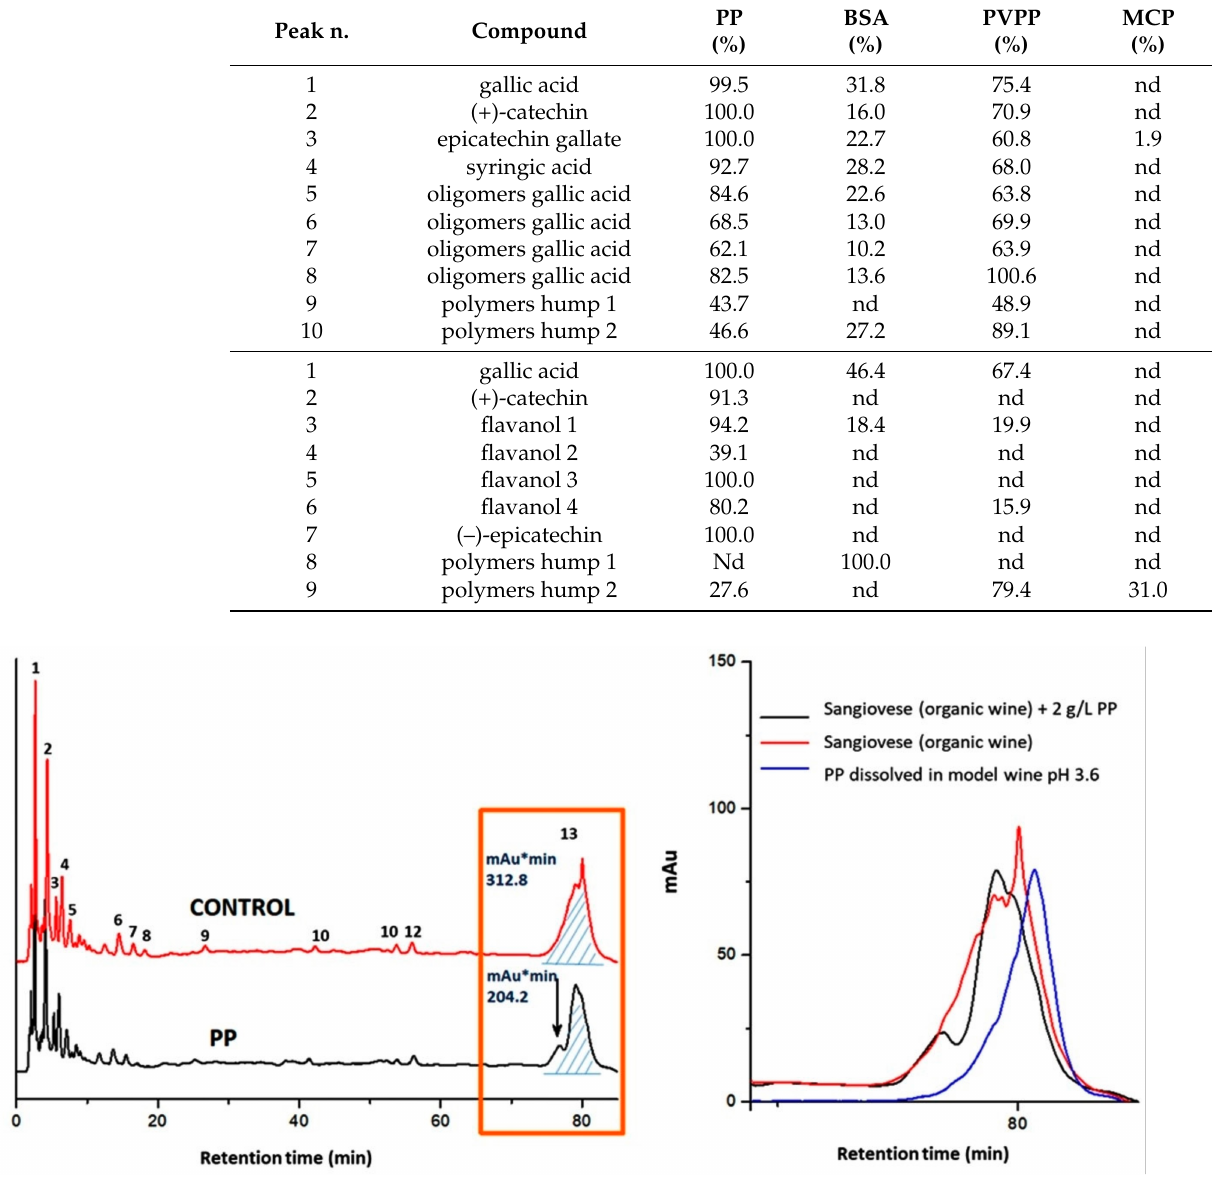
Table 2. Effect of fining agent on adsorption of phenolic compounds (%) from model wine solutions with gallotannin (top) and grape seed proanthocyanidin (bottom) at 0.6 g/L. For each fining agent, values of HPLC peak area are normalized to percentage compared with control (100%). See Figure 2 for peak numbering. Legend: Patatin (PP); Bovine Serum Albumin (BSA); Polyvinylpolypyrrolidone